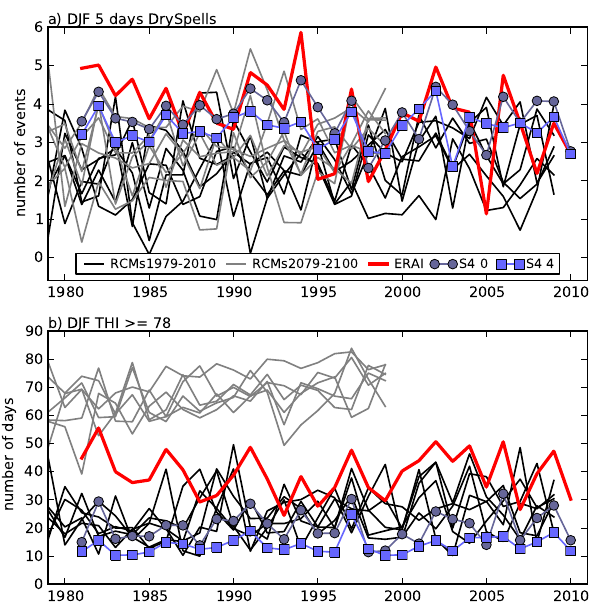
Fig. 6. Time series of the DJF frequency of occurrence of 5-day dry spells (a) and frequency of occurrence of days with THI higher than 78 (b) averaged over the Limpopo region (see basin outline in previous maps). The time series are displayed for ERA-Interim (red line) and ECMWF S4 forecasts initialized in December (0months lead time – dark blue) and August (4months lead time – light blue). The black lines display the temporal evolution of the regional cli- mate models between 1979 and 2010 and the gray lines between 2079 and 2100.